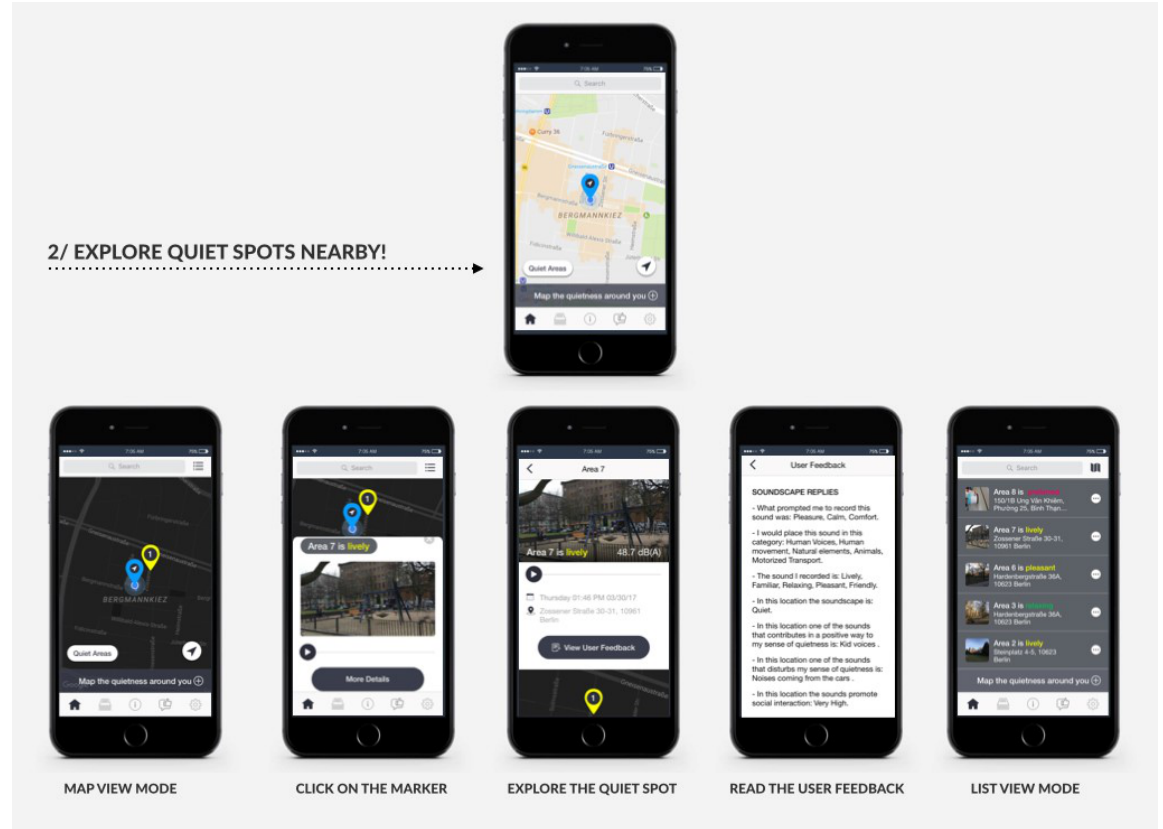
Figure 4: The Hush City app: “Quiet Areas” interface. © A. Radicchi 2017